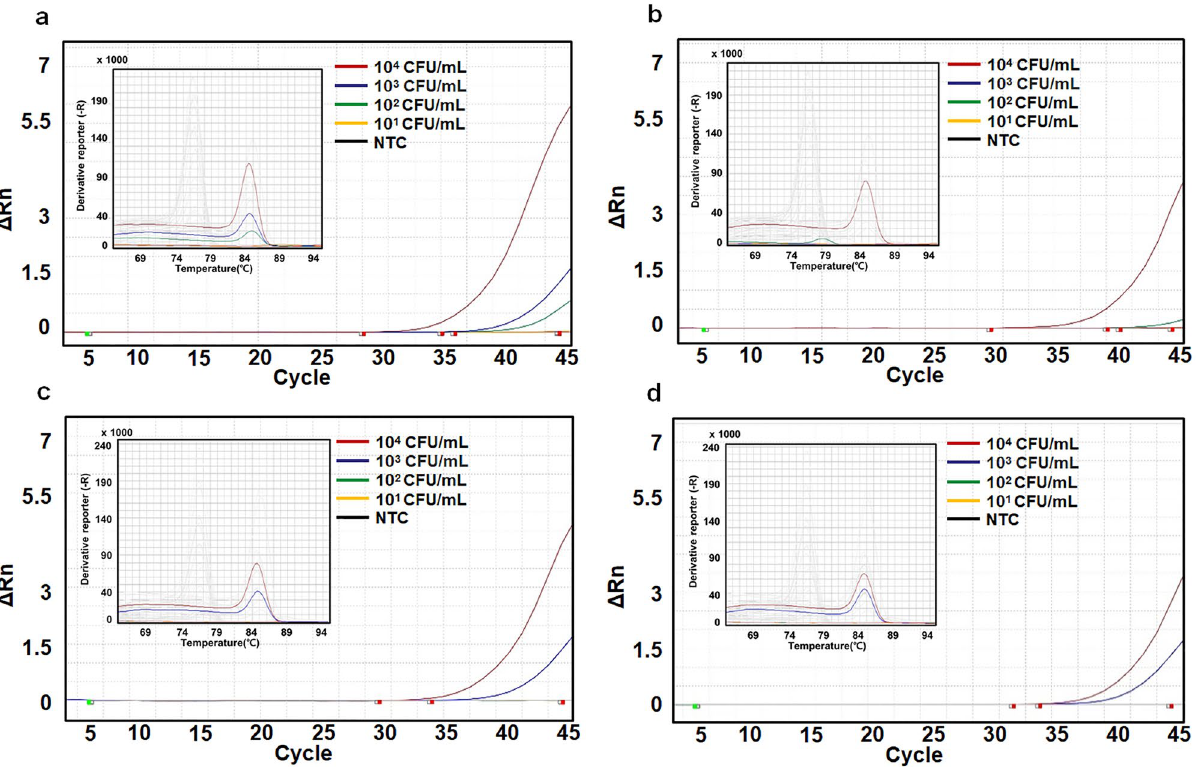
Figure 4. Results of real-time PCR for the detection of E. coli . Each figure shows amplification and melting curves. The CFU (colony forming unit) values in each figure are the concentrations at the time of spiking and are independent of specimen incubation. The quantified actual numbers of E. coli in plasma with different concentration (10 1 –10 4 CFU/mL) after 12 h specimen incubation at RT are 98.3 ± 22.4, 741 ± 98, 6,210 ± 1540, and 53,300 ± 12,700, respectively (Supplementary Table S3). Nucleic acid amplification and melting curves in each figure are dependent on specimen incubation. ( a ) Real-time PCR results after 12 h incubation and with E. coli captured by MNBs, ( b ) after 12 h incubation and with E. coli uncaptured by MNBs, ( c ) without prior specimen incubation and with E. coli captured by MNBs, ( d ) without prior specimen incubation and with E. coli uncaptured by MNBs.